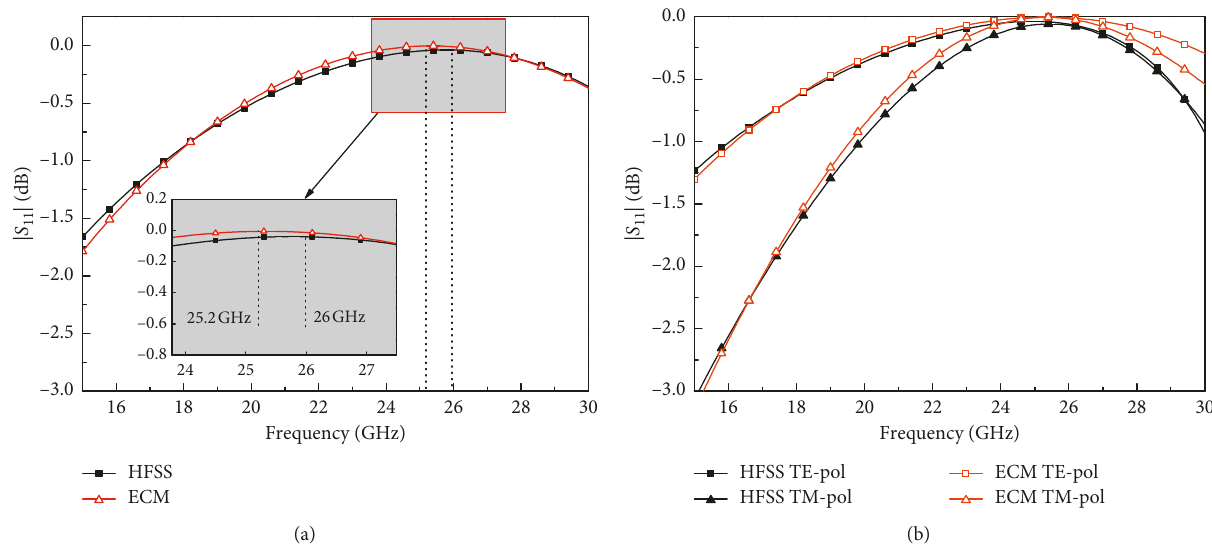
Figure 4: Comparison of the reflection coefficients | S (b) Oblique incidence with θ � 45 ° and different polarizations.